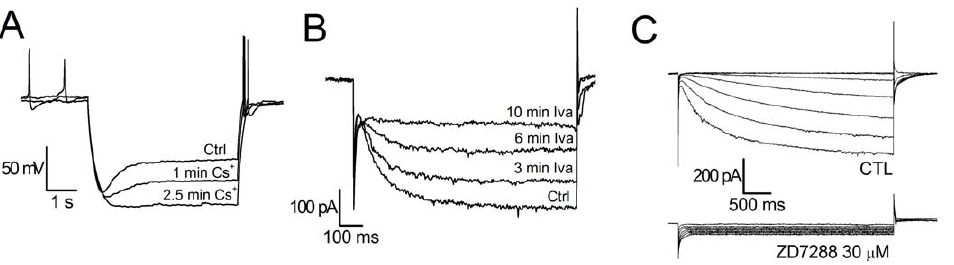
Figure 5. Basic pharmacology of h-current. A: Blockage by Cs + (1 mM): current-clamp responses to a repeated hyperpolarizing current step of 300 pA from a holding potential of 2 60 mV. Note the progressive suppression of the sag after the indicated times of Cs + application; T 37 u C. B: Blockage by ivabradine (10 m M): voltage clamp responses to a repeated hyperpolarizing step to 2 130 mV from a holding potential of 2 40 mV at the indicated times of drug application; T 37 u C. C: Blockage by ZD7288 (30 m M); holding potential 2 40 mV, test potentials ranging from 2 70 to 2 130 mV; T 27 u C, Ba2 + 0.5 mM present throughout.